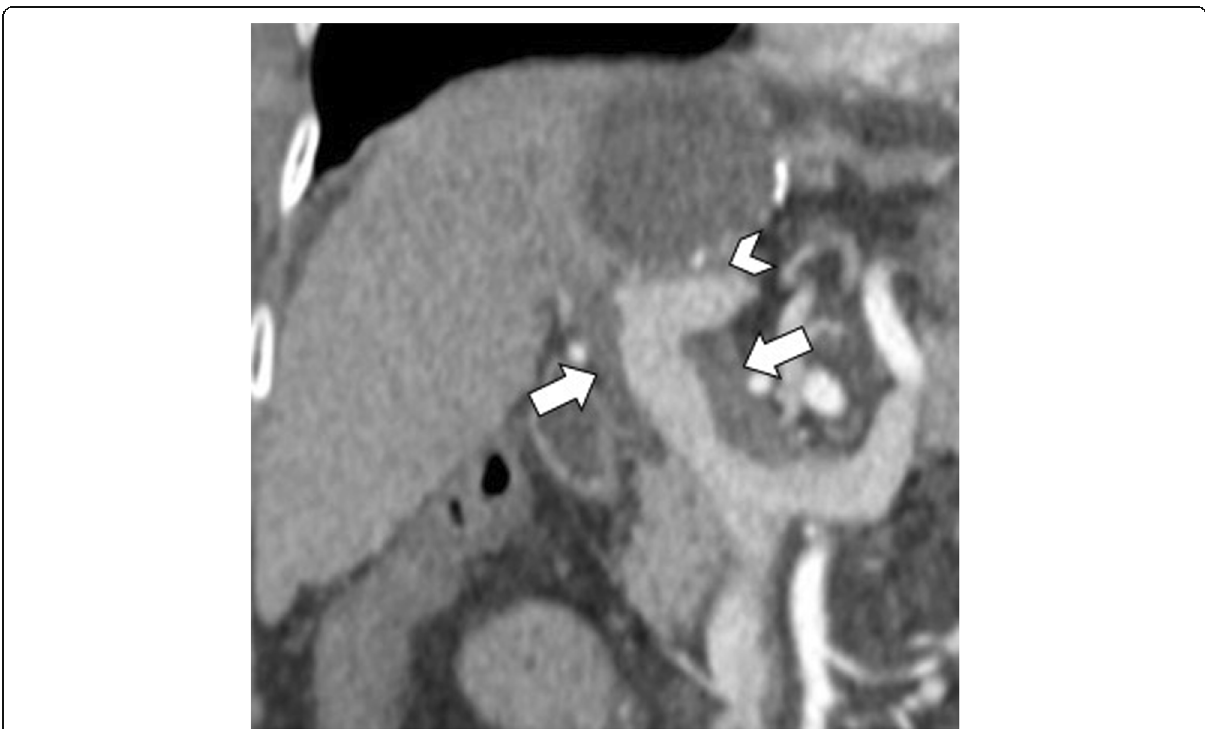
Fig. 17 A 72-year-old woman with hydatid cyst and portal vein thrombosis. Oblique reformatted CT image on portal venous phase shows a large hepatic hydatid cyst adjacent to the left branch of portal vein (arrowhead) and partial portal vein thrombosis